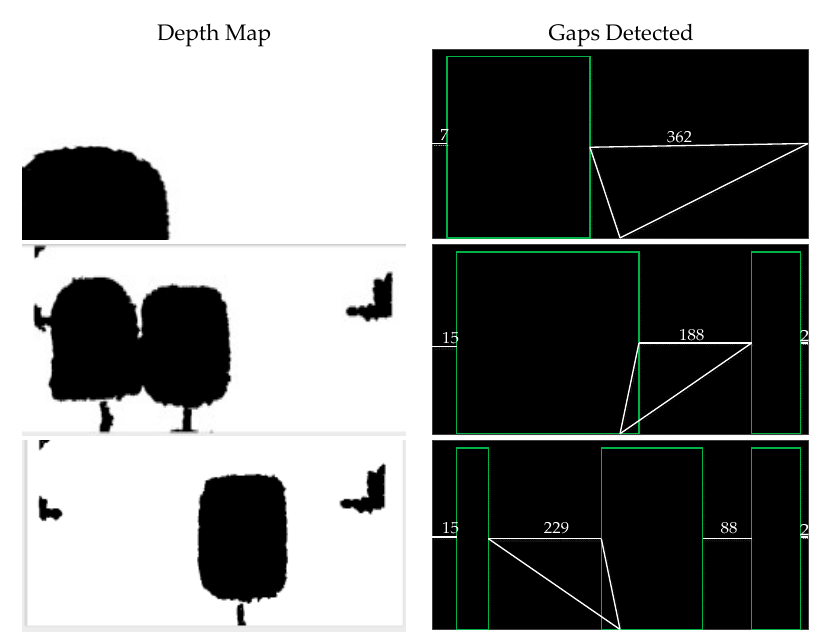
Figure 6. Threshold depth maps and detected